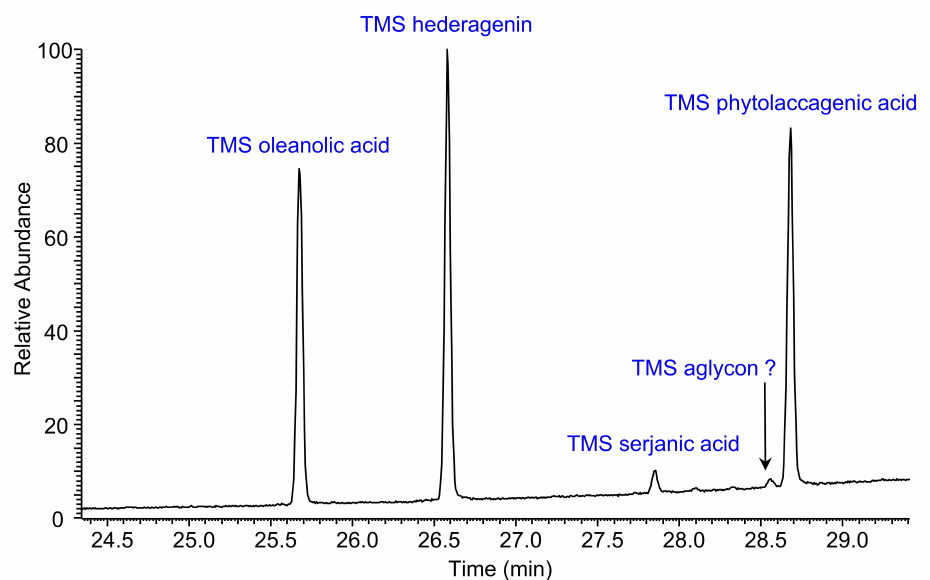
Figure 1. Ion mass chromatogram of trimethylsilylated sapogenins from C. quinoa obtained by GC-MS. GC-MS chromatogram profile shows the separated sapogenins from C. quinoa seed extract. Saponins were quantified by indirect quantification of their corresponding sapogenins derived from the hydrolysis of saponins from C. quinoa seed. Mass spectra of silylated oleanolic acid, hederagenin, serjanic acid, and phytolaccagenic acid were assigned by comparison of retention times (25.7, 26.6, 27.9, and 28.7 min, respectively) and mass spectra to the corresponding